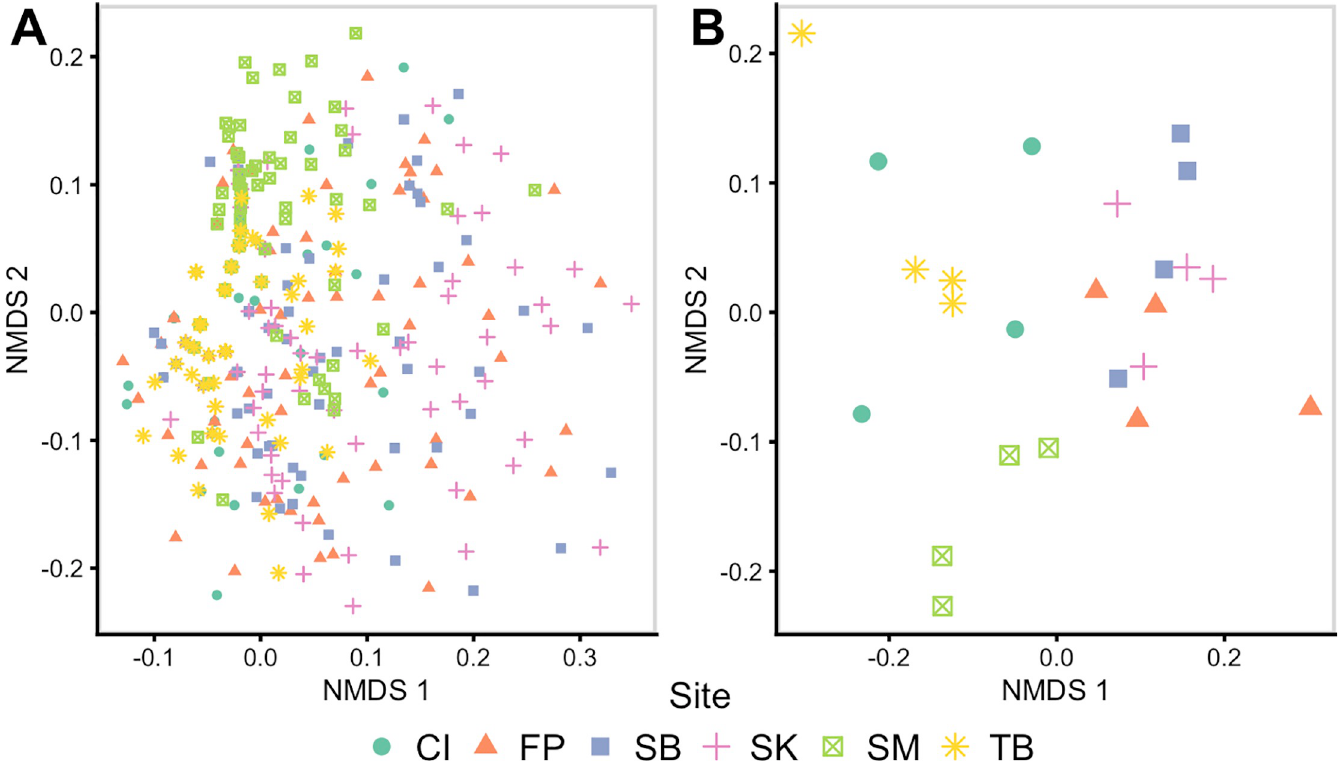
Fig 2. Non-metric multidimensional scaling plots of parasite infracommunities (A) and component communities (B) of the salt marsh fish, F . heteroclitus , from 6 sites in coastal Georgia, USA. Infracommunity (A) distances are based on Bray-Curtis dissimilarities of the ln(x +1) transformed abundances of 8 parasite taxa. Component community (B) distances are based on Bray-Curtis dissimilarities of the square-root transformed average abundances of 8 parasite taxa. The sites include: Fort Pulaski (FP) (salmon triangles), Cockspur Island (CI) (aquamarine circles), Tybee (TB) (yellow stars), and Skidaway Island (SK) (pink crosses) in the Savannah River Estuary; Shellman Bluff (SB) (blue squares) as a representative of the Sapelo Sound; and St. Marys (SM) (green crossed squares) as part of the St. Marys Estuary.